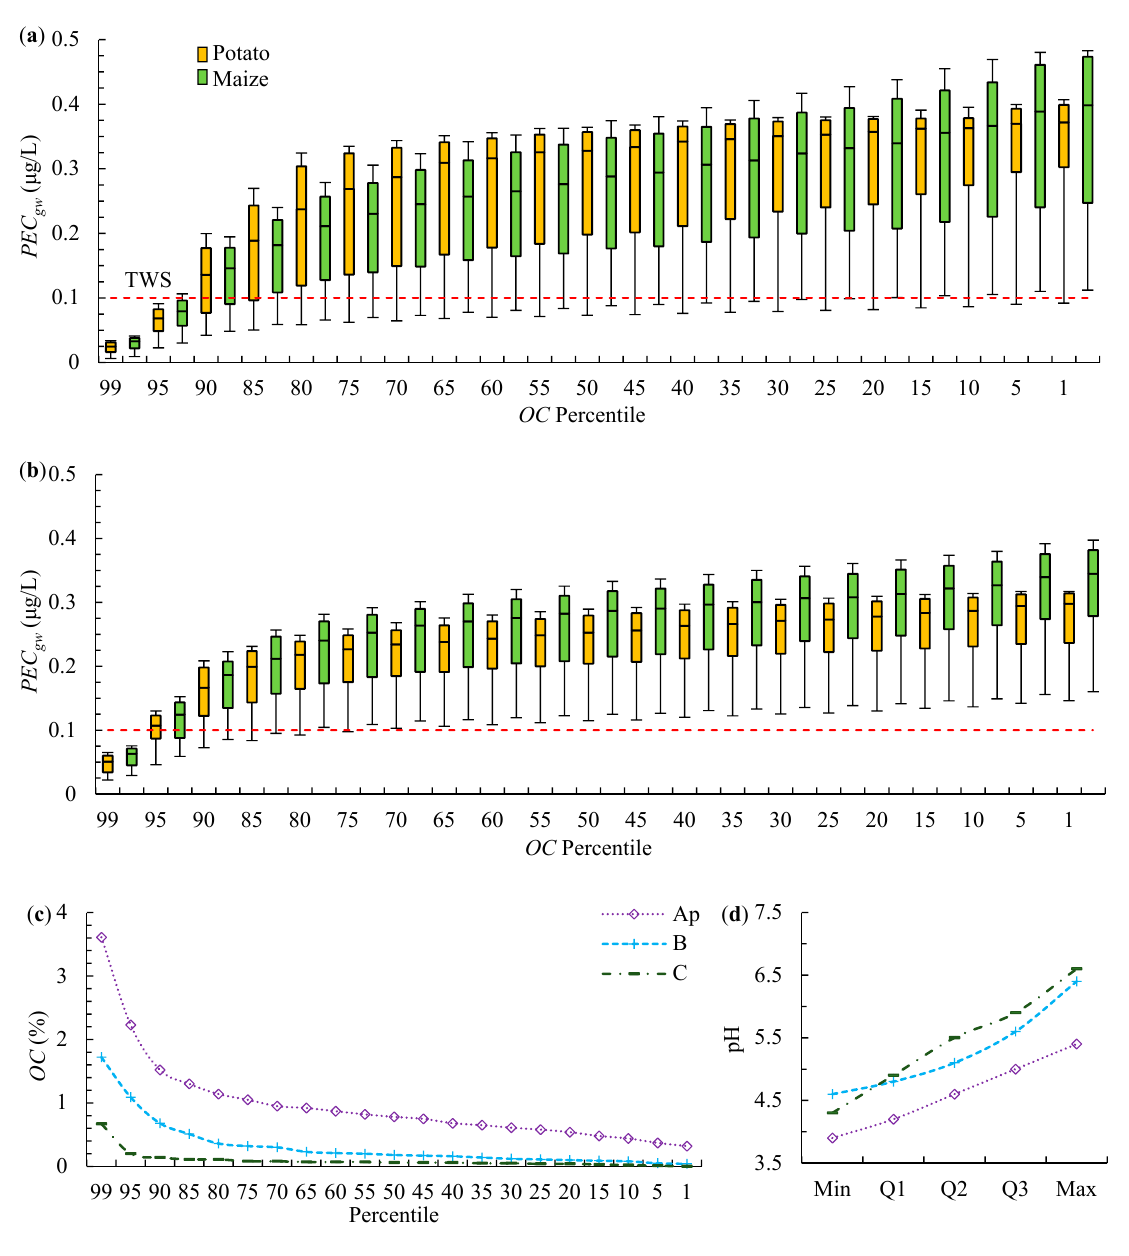
Figure 3. Predicted values of PEC gw for potato and maize cultivation in the model of AR profiles with varied OC content and pH for: ( a ) Lublin and ( b ) Hamburg climate. Box and whiskers plots denote the values of PEC gw estimated for the respective percentiles of OC content at minimum, first quartile (Q1), median (Q2), third quartile (Q3), and maximum pH values. ( c ) Percentiles of OC contents and ( d ) range of pH values of AR profiles.